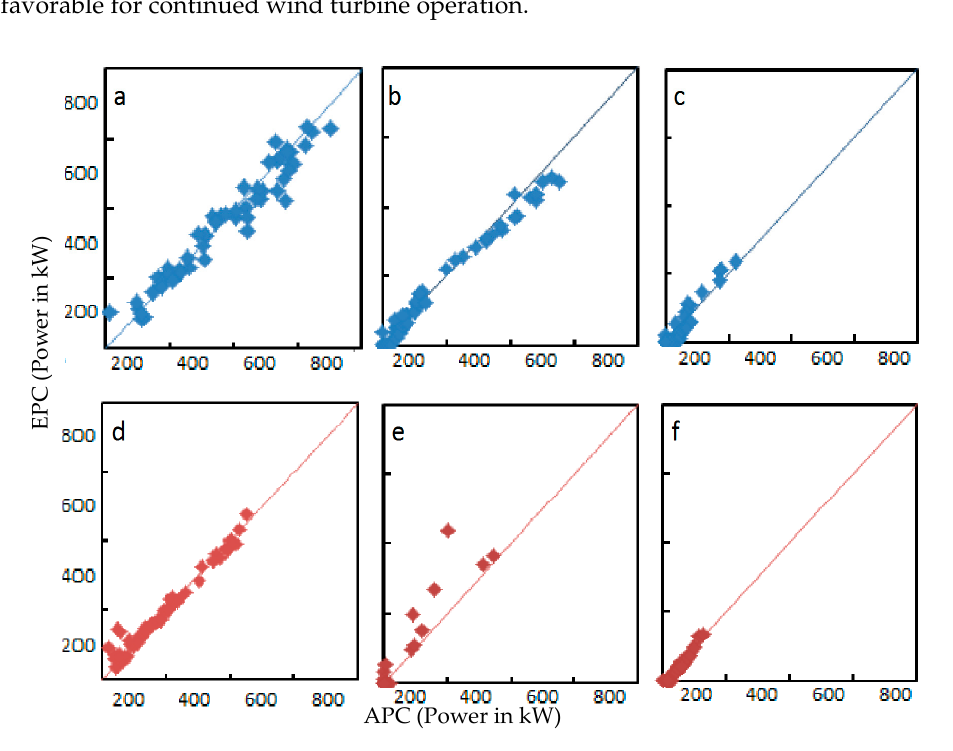
Table 4. Statistical performance of the effective power curve.